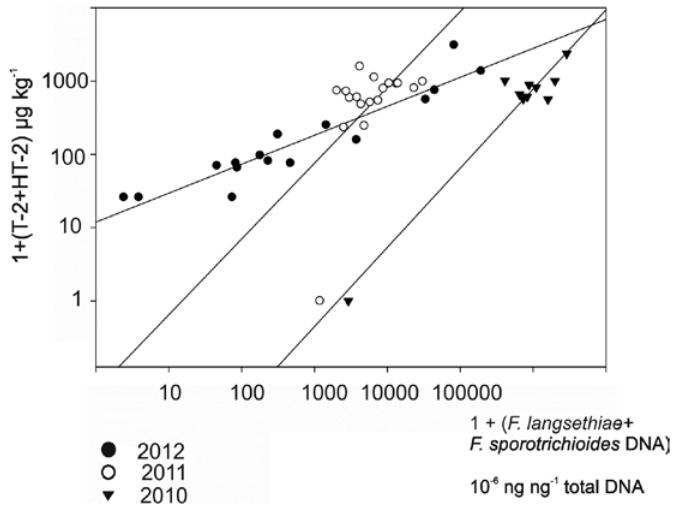
Figure 3. Correlation between TMLAN DNA and HT-2/T-2 levels in oats in 2010, 2011 and 2012. R 2 = 0.94 *** (2010), 0.30 * (2011), 0.89 *** (2012). Regression slopes are shown. *** means highly significant ( p < 0.001) and * means significant ( p <